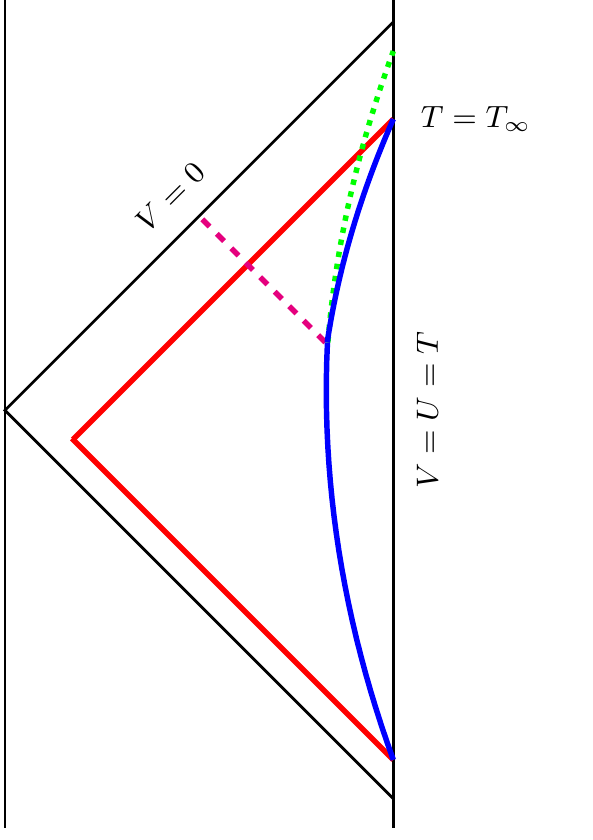
Figure 3 . Penrose diagram illustrating the near-horizon computation of late-time behavior includ- ing the e(cid:11)ects of backreaction. The physical boundary, in solid blue, is promoted to a degree of freedom encoding the black hole’s (small) deviation from extremality. The red solid lines are the future and past horizons. The magenta dashed line depicts a possible initial data surface, or an advanced time in which the BH is perturbed from afar. The dotted green line shows the later part of the boundary trajectory had the scalar (cid:12)eld not been excited. The late-time behavior of (cid:12)elds, as in (cid:12)gure 2, is determined by analyzing the neighborhood of the point T = T 1 . the correct value of the (cid:12)eld near the boundary. 15 In fact, with our choice of